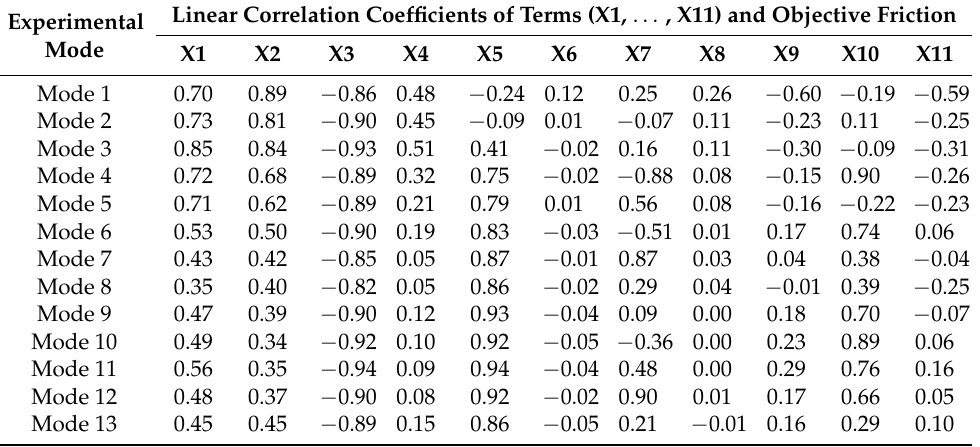
Table 2. Linear correlation coefficients of terms and objective friction at each different experimental